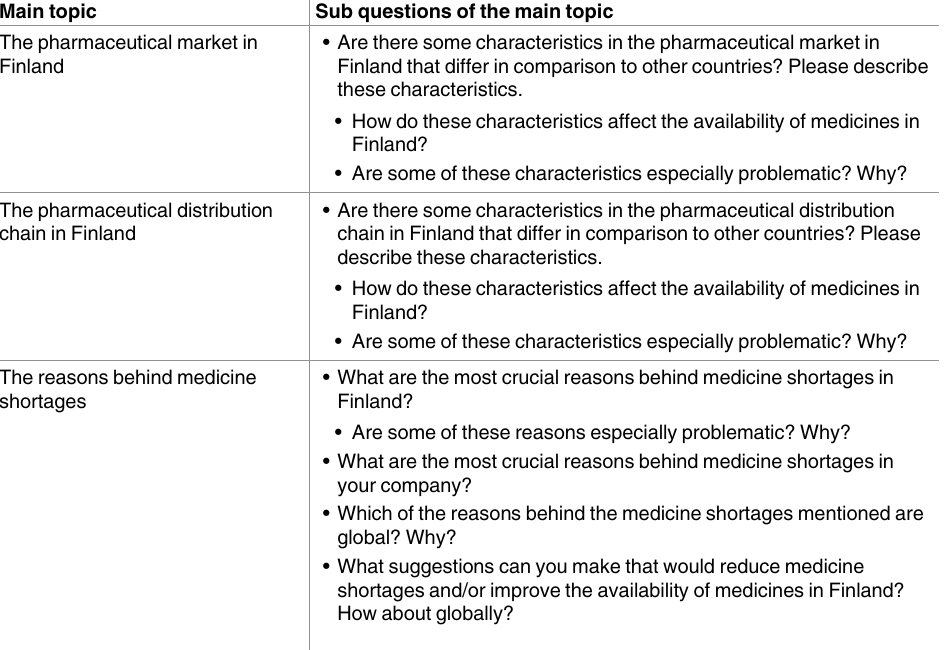
Table 1. The interview